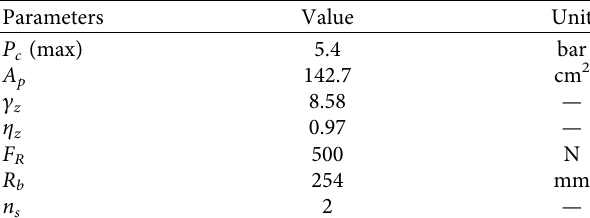
Table 4: Parameters of braking